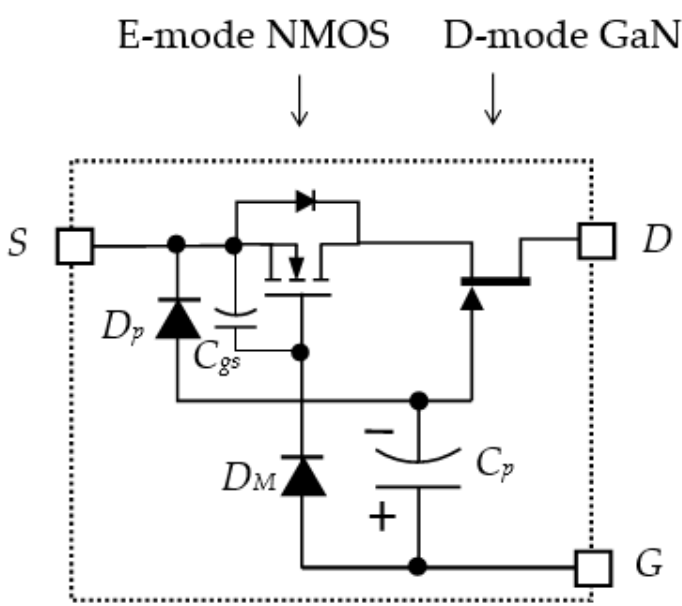
Figure 5. The GaN-switching cascode GaN HEMT power